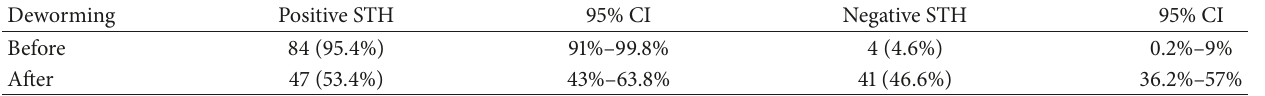
Table 2: The prevalence of STH before and after deworming.